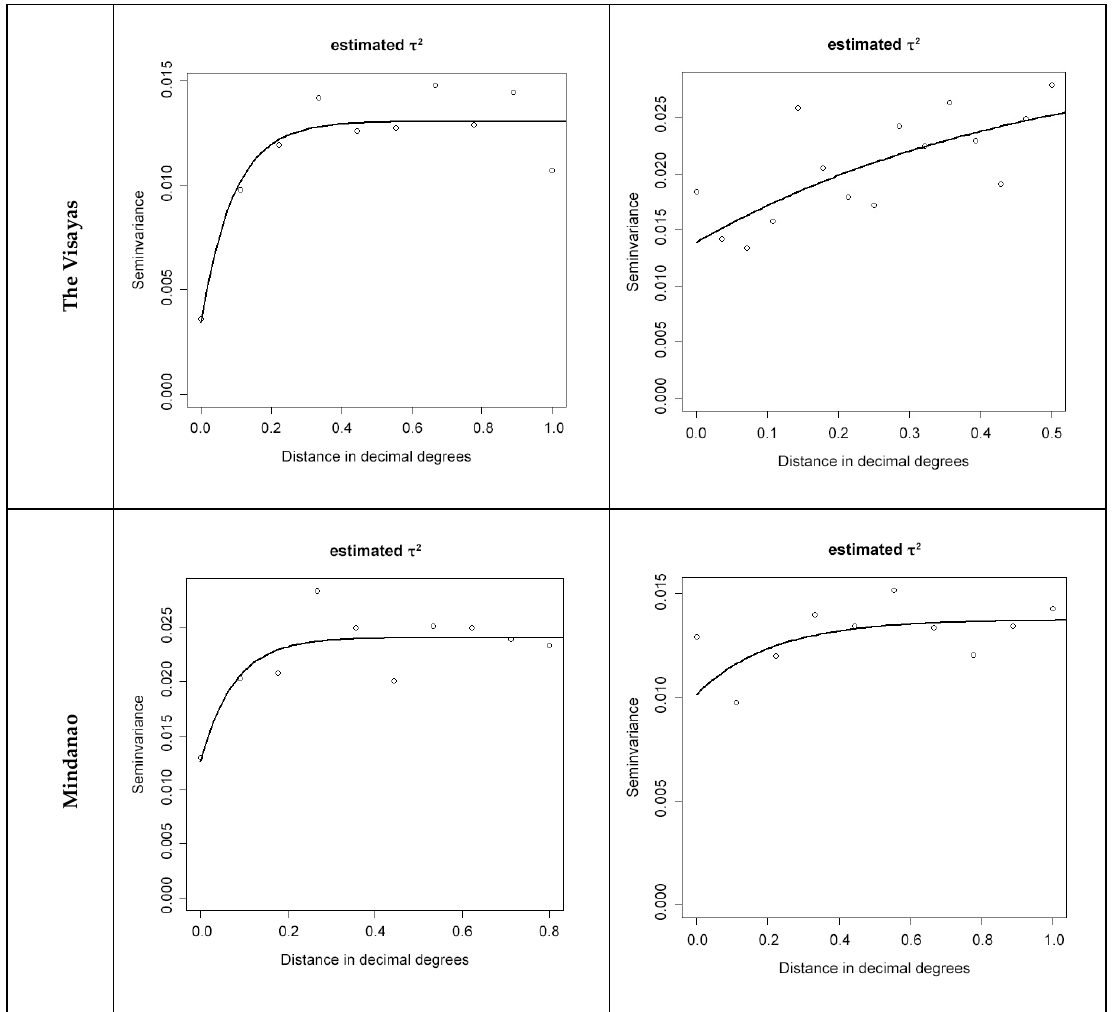
Figure 3. Semivariograms of prevalence of functional illiteracy in school-aged children. Table 6. Results of semivariograms for prevalence of functional illiteracy and moderate and low functional literacy.